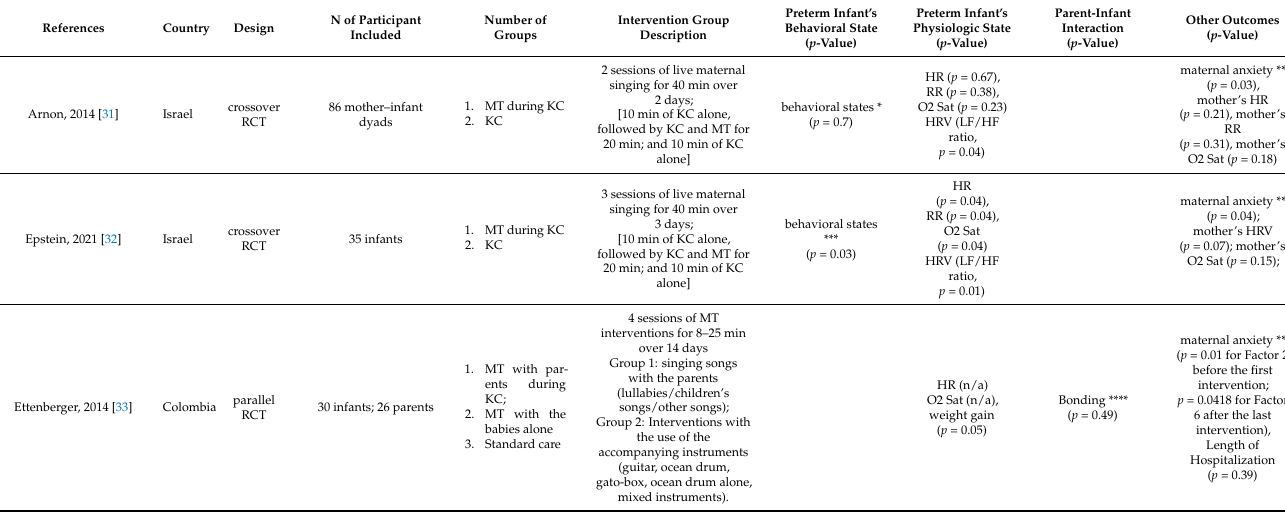
Table 1. Study characteristics on music therapy during kangaroo care focusing on the preterm infants’ responses and parent-infant